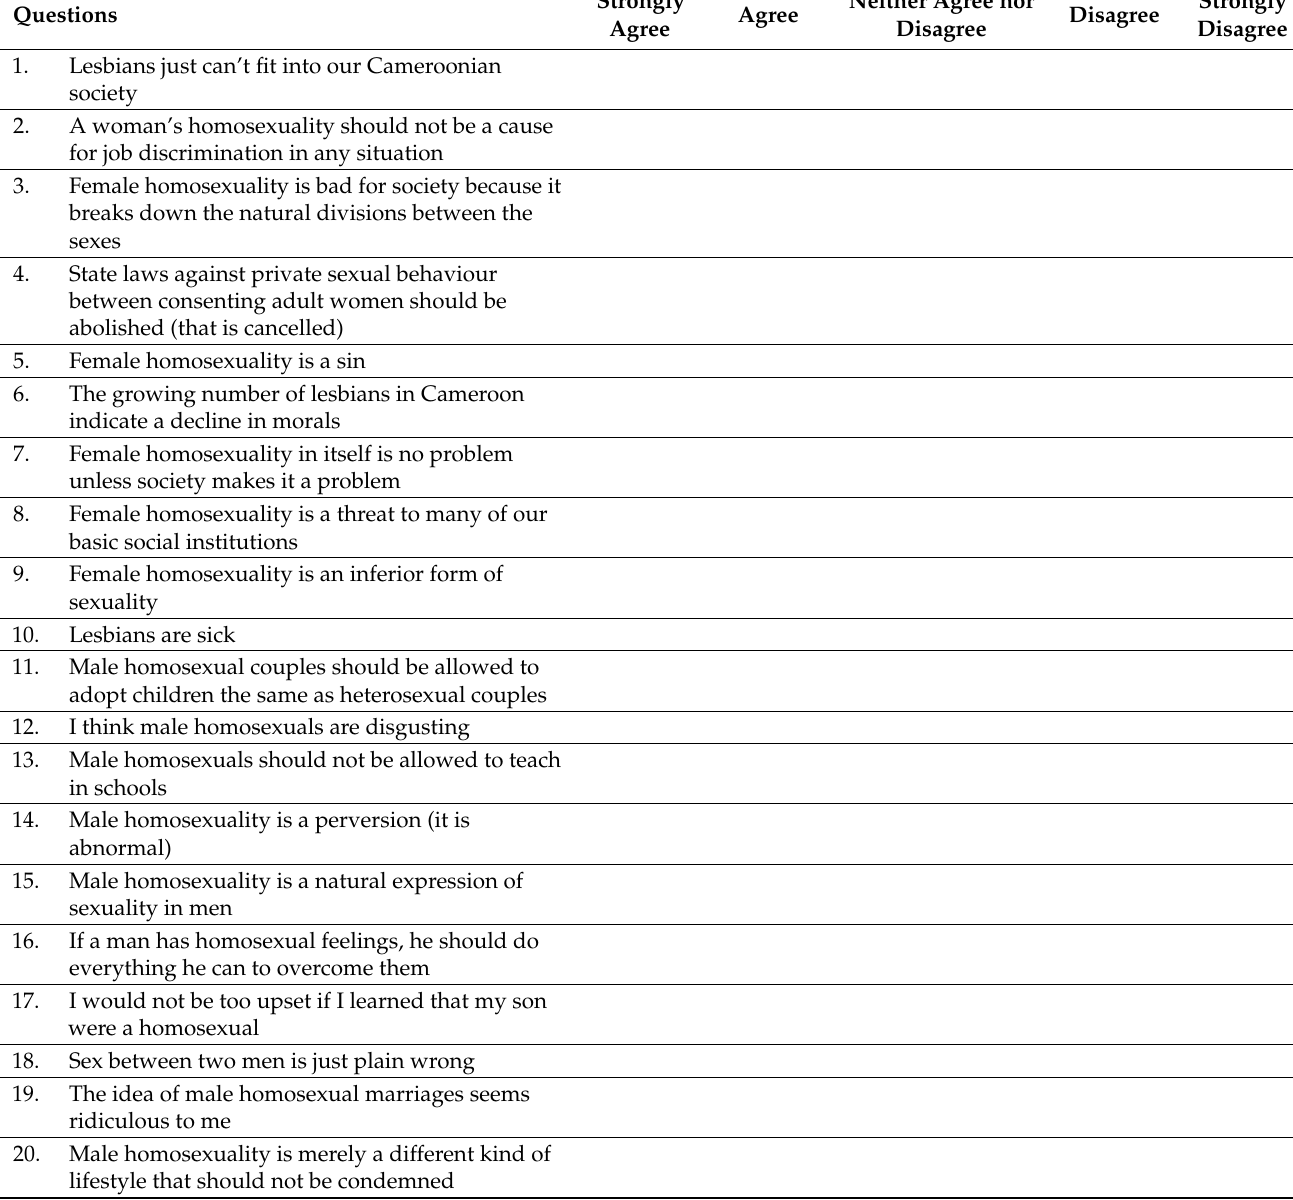
Table A1. Adaptation of Herek’s ATLG Scale in